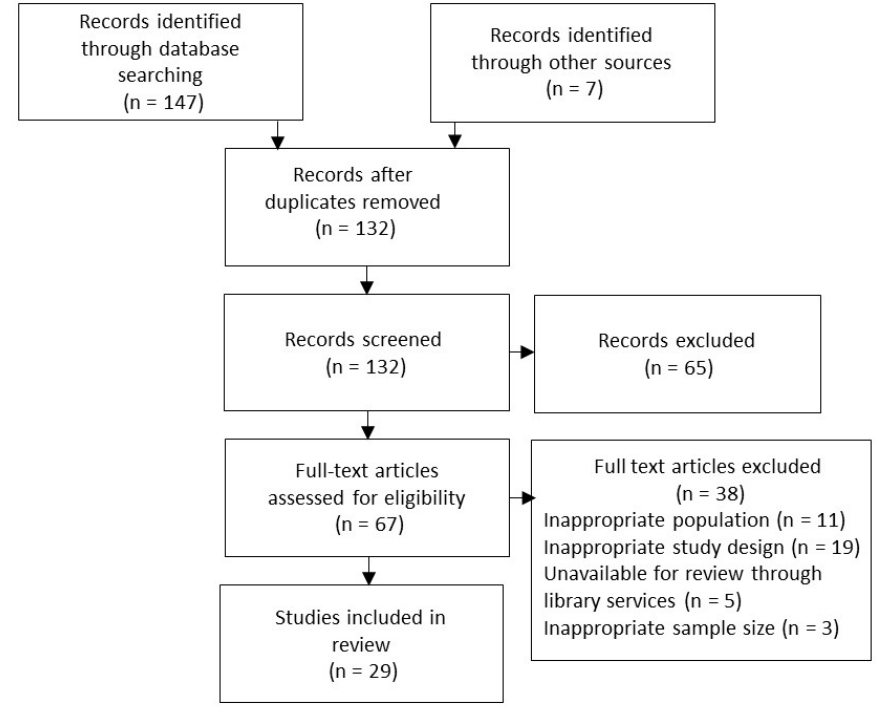
Figure 1. Search strategy flow chart.